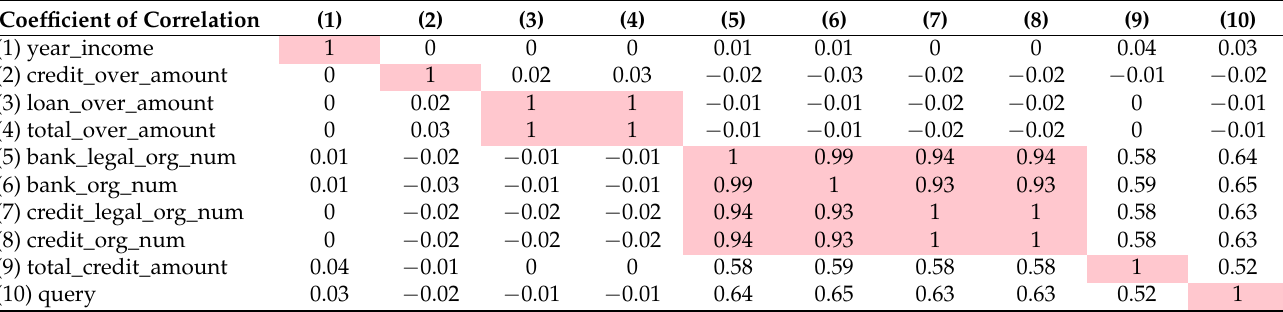
Table 3. Correlation matrices of some variables.